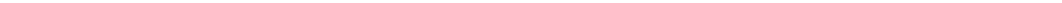
(see fi gure on previous page) Fig. 8 CircPSMA1 facilitates tumorigenesis, migration, and metastasis of TNBC cells in vivo. A Representative images of tumors of circPSMA1- overexpressing group ( n = 7) or NC groups ( n = 7). B Growth curves of tumors were measured weekly. C Tumor weight. D Immunohistochemistry (IHC) staining showed the protein levels of Akt1 and Akt1-related molecules ( β -catenin, cyclin D1, and Bax) (magni fi cation, ×200, Scale bar, 100 μ m). E The protein level of Akt1 and Akt1-related molecules were detected by western blot. F – H The appearance and HE stain images of livers in two groups (magni fi cation, ×100, Scale bar, 100 μ m). I – J The HE stain images of lungs in two groups (magni fi cation, ×50, Scale bar, 100 μ m). K – L Kaplan – Meier survival analysis of overall survival (OS) in TNBC patients with lymphatic metastases based on TCGA data according to the Akt1 ( n = 107) or miR-637 expression ( n = 32). M The illustration of how circPSMA1/miR-637/Akt1 axis promoted TNBC cell proliferation, migration, and metastasis. CircPSMA1 functions as a sponge of miR-637 and downregulates miR-637 expression, and then increases Akt1 expression by directly binding miR-637 with the 3 ′ -UTR of Akt1. Akt1 can upregulate cyclin D1 expression and lead to G1/S phase cell cycle arrest; Akt1 can upregulate β -catenin expression and cause to tumor migration and metastasis; Akt1 can downregulate Bax expression and thereby inhibiting cell apoptosis. Therefore, circPSMA1 promoted TNBC cell proliferation, migration and metastasis through circPSMA1/miR-637/Akt1/ β -catenin (cyclin D1)